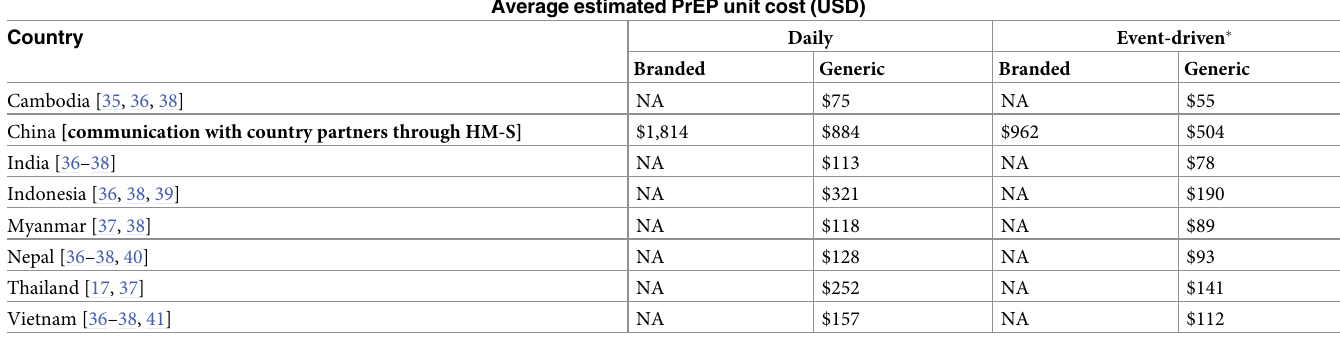
Table 1. PrEP unit